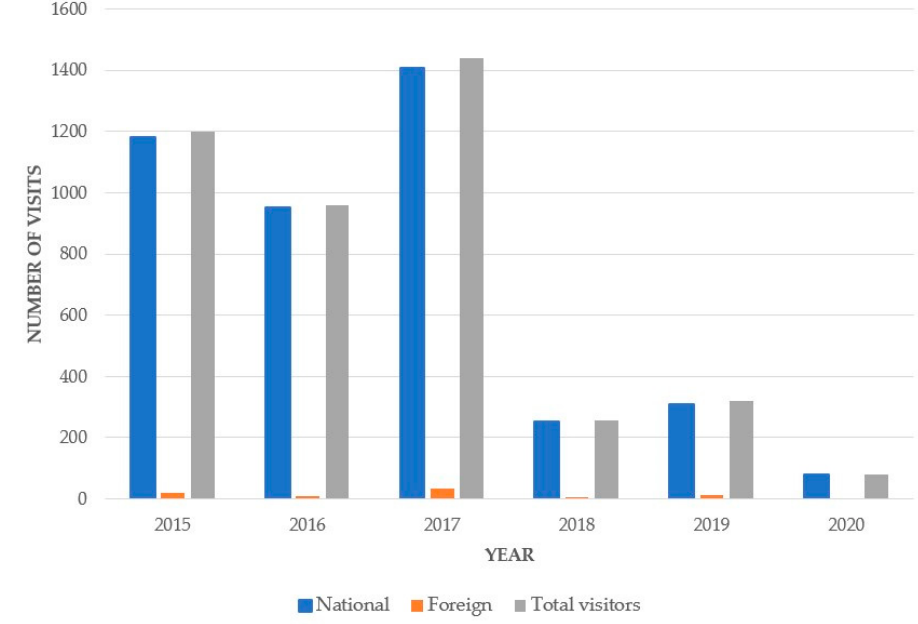
Figure 4. Annual visit data of the MMMT. Source: MMMT.